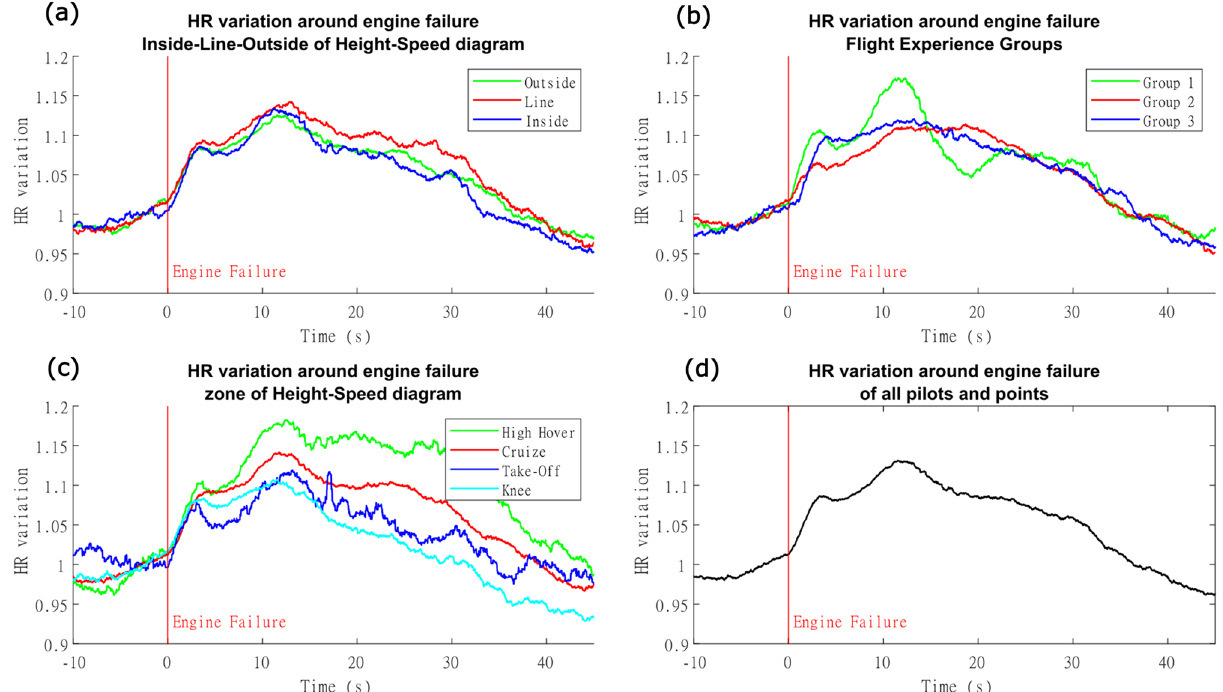
Figure 7. Heart rate changes around the engine failure: (a) HR changes during maneuvers inside, outside or at the line limit of the height-speed diagram. (b) HR changes between different groups of pilot expertise: